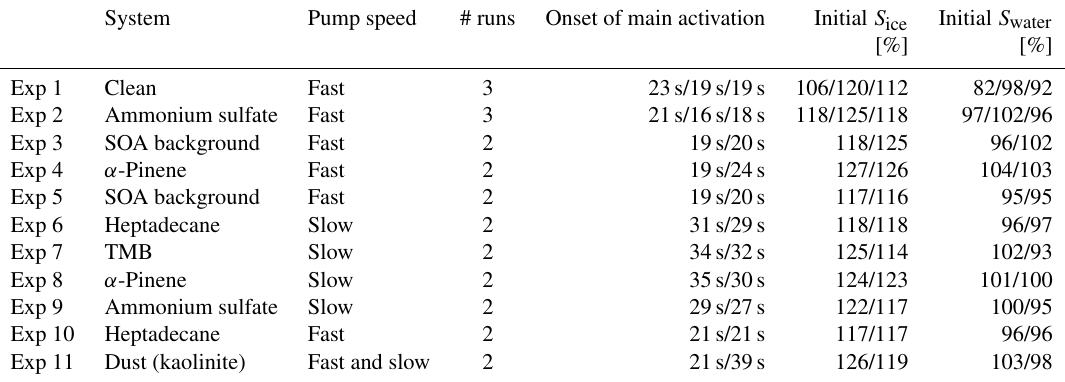
Table 1. Overview of the conducted experiments, indicating pump speeds, number of cloud runs performed, times of cloud droplet activation in seconds from start of cloud expansion, and initial S ice and initial S water for first/second(/third) cloud